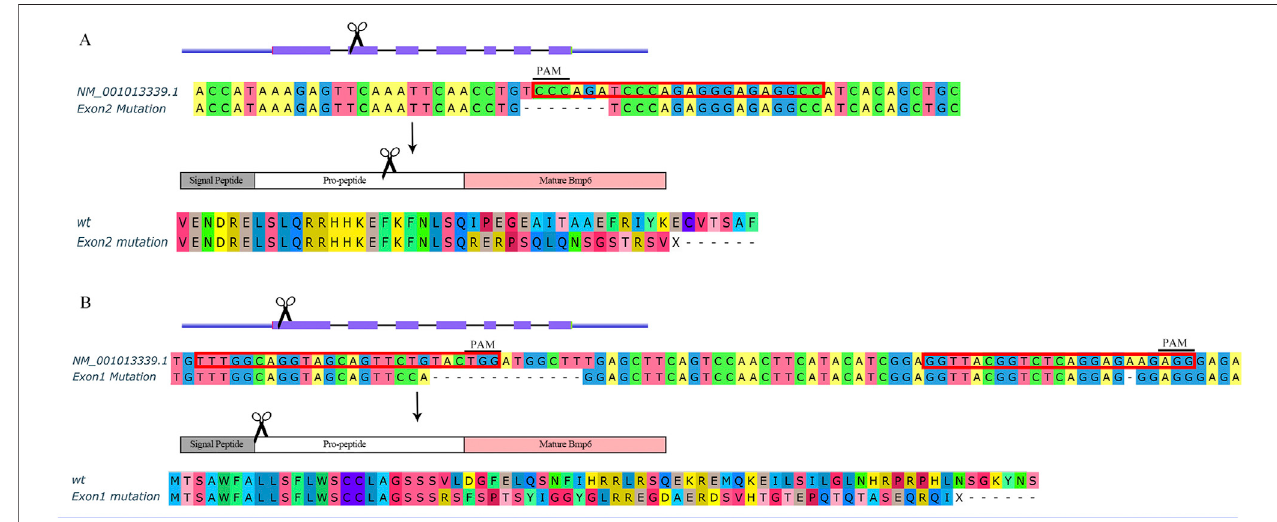
FIGURE 1 | Schematic of bmp6 knockout. (A) Knockout bmp6 on exon 2 in group M. (B) Knockout bmp6 on exon 1 in group A. Sequences with red border are target sites including PAM sites for CRISPR/Cas9.